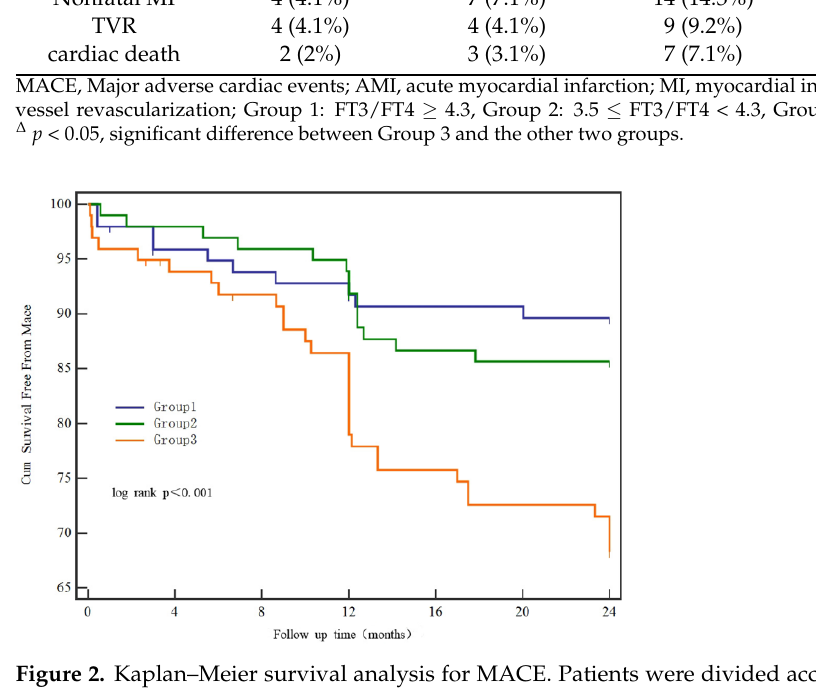
Table 4. Cox regression analysis of factors associated with major adverse cardiac events. Univariable Analysis